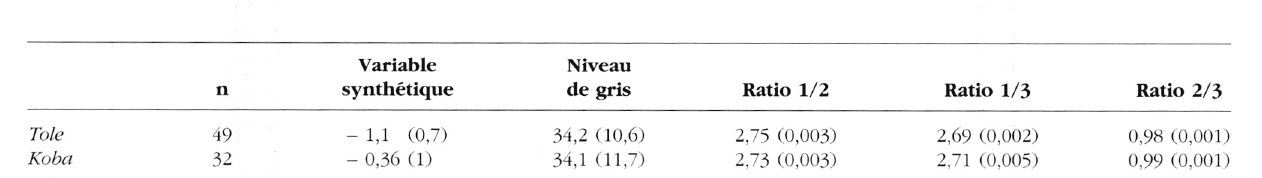
hébergent des populations de G. tach in oid es de manière permanente (de La Rocque, 1997). Les résul­ tats des mesures apparaissent dans le tableau III. L'effet géographique est nettement significatif sur la